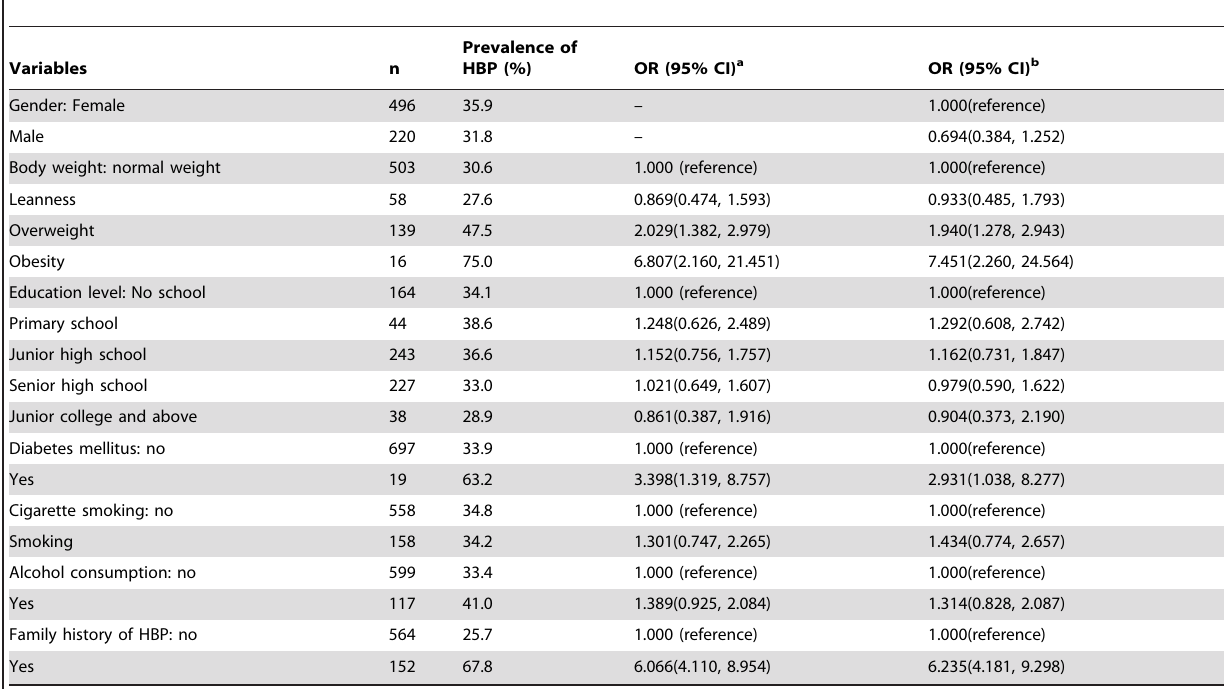
Table 4. Factors associated with the prevalence of hypertension from multivariate logistic regression models in age group 50–59 (N=